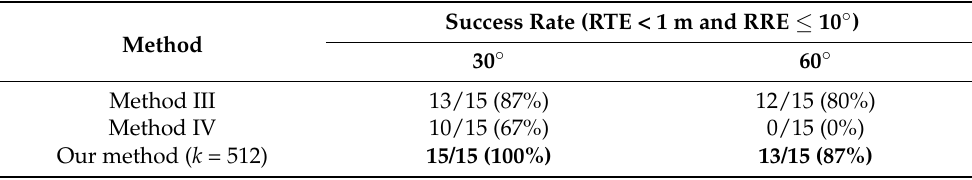
Table 4. Registration results of each method from scan #34 to scan #33 in Dataset I.